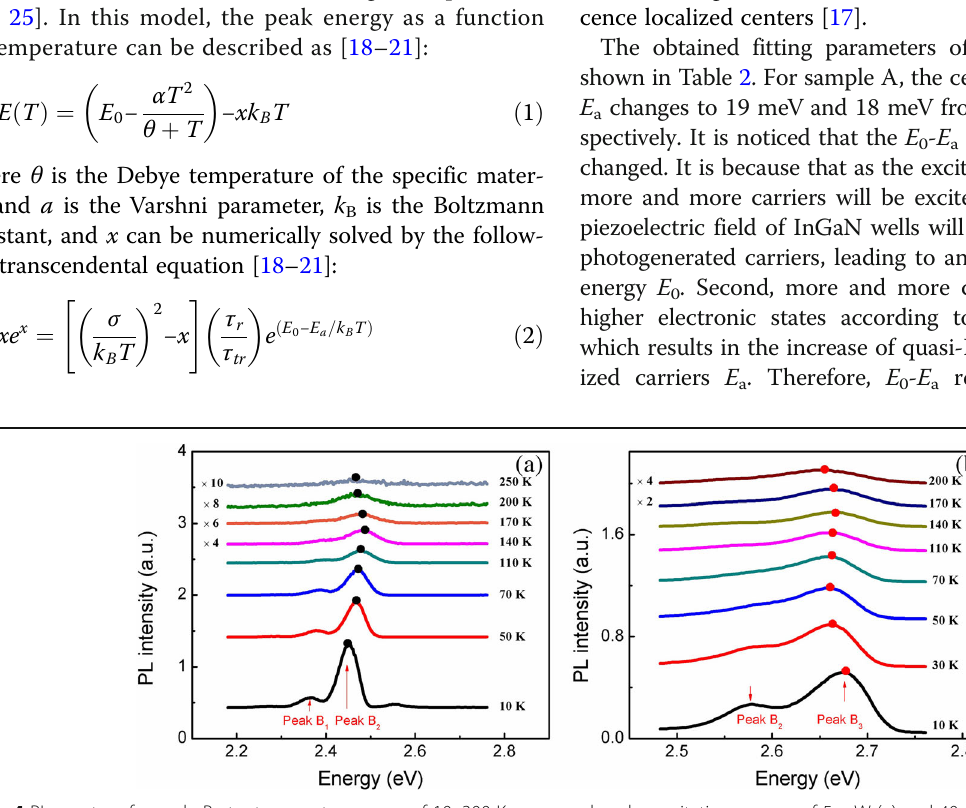
Fig. 4 PL spectra of sample B at a temperature range of 10 – 300 K, measured under excitation powers of 5 mW ( a ) and 40 mW ( b